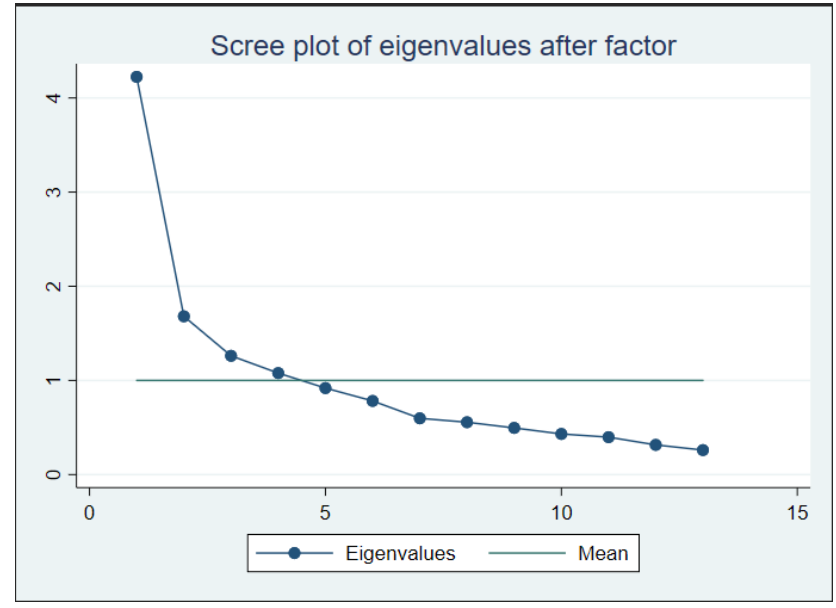
Graph 1: Scree Plot of Eigenvalues after Factor Extraction